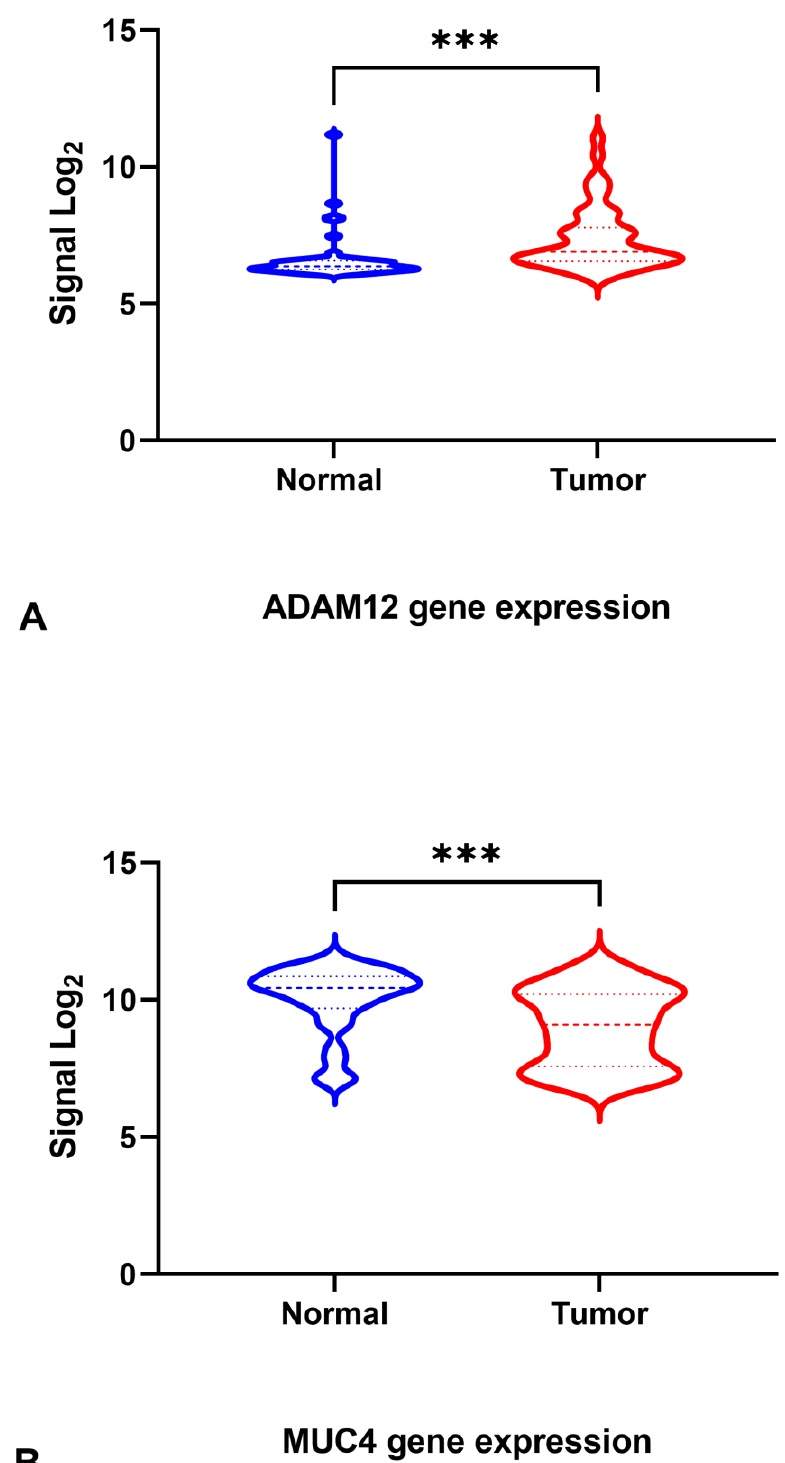
Figure 1. Analysis of microarray data for tumor and adjacent normal samples from patients with CRC. ( A ): Expression of ADAM12 in a previous microarray study. ADAM12 was significantly upregulated in tumor samples. ( B ): The expression of MUC4 in a previous microarray study. MUC4 was significantly downregulated in tumor samples. Graphs represent data from 48 patients with CRC. Welch’s t -test was used to determine statistical significance. *** denotes p -value <